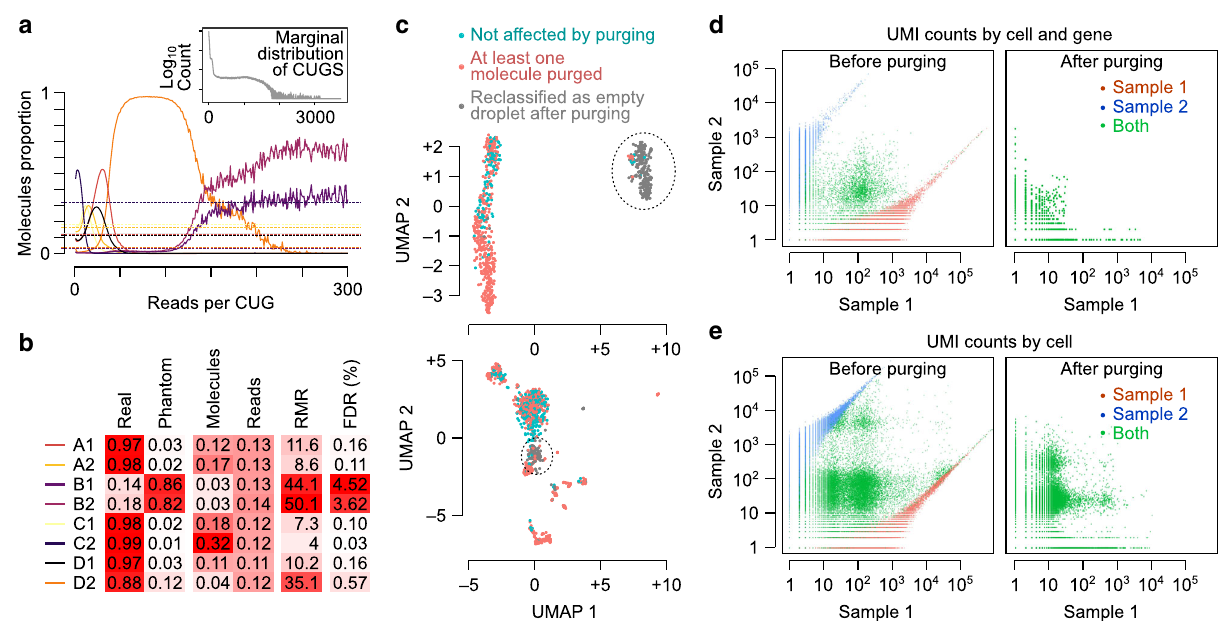
Fig. 4 Impact of sample index hopping. a The molecular proportions complexity (MPC) pro fi le of a dataset of eight samples sequenced on HiSeq 4000 7 . Each curve represents one sample, with the y -axis showing the proportion of molecules that belong to that sample conditional on the PCR ampli fi cation level (i.e., reads per CUG, r , which is shown on the x -axis). The MPC pro fi le is shown for r ≤ 300 since there are few CUGs beyond that point to enable accurate estimation of molecular proportions. b The proportion of real and phantom molecules in each of the eight samples, the fraction of molecules and mapped reads that belong to each sample, the read-to-molecule ratio (RMR) per sample, and the corresponding FDR statistics (i.e., the within-sample proportion of molecules that we miss-classify as real after purging) for the HiSeq 4000 dataset. See Supplementary Tables 5 – 6 for additional datasets. c Example cases showing the effect of index hopping on cell type identi fi cation. The graphs show the UMAP embedding of cells, based on non-purged data, in two samples from the Tabula Muris dataset 8 (top: sample P7-1; bottom: sample P7-8; UMAP embedding based on normalized gene expression pro fi les). Dotted circles highlight two clusters that are almost entirely made up of cells that are reclassi fi ed as empty droplets after purging phantom molecules. d The effect of purging on gene expression pro fi ling in the validation dataset with known ground truth. Each dot represents one gene expression measurement in one cell. Dots are colored based on cell-sample assignment in the ground truth, with red and blue representing cell barcodes that are found only in sample 1 or sample 2, respectively. Green represents cell barcodes that are found in both samples (barcode collision). Note that the nonzero sample 1 UMI counts for blue dots and nonzero sample 2 UMI counts for red dots represent phantom molecules. e Same as ( d ), but with the counts aggregated per cell (each dots represents one cell). Blue dots with high counts in sample 1 and red dots with high counts in sample 2 represent phantom cells. Green dots represent potential transcriptome